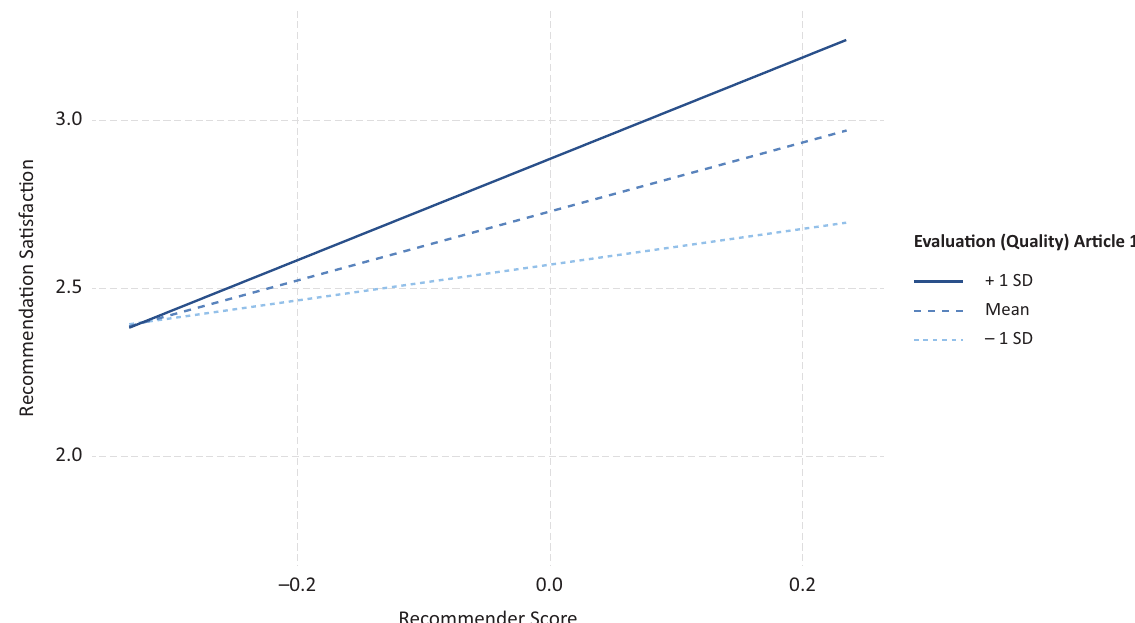
Figure 1. Moderating effect (n.s.) of quality article 1 on the conditional effect of text similarity on recommendation satis‐